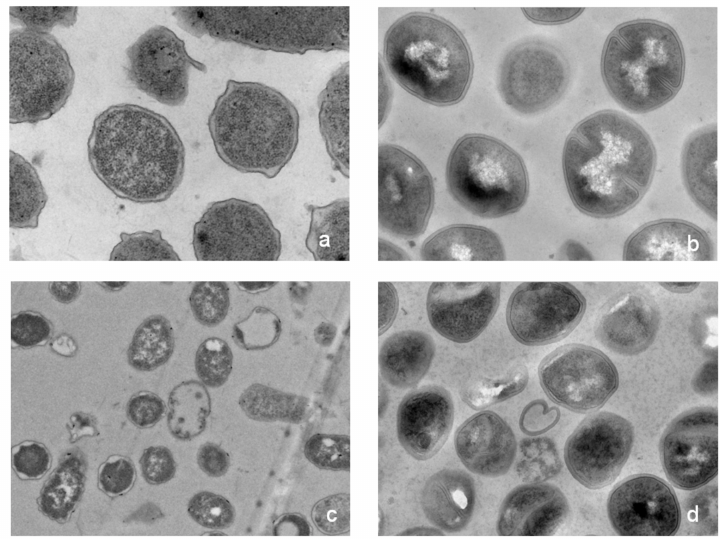
Figure 7. Transmission electron micrographs (TEM) of E. coli and S. aureus . Bacteria in mid-logarithmic growth were treated with peptides at 1 × MIC for three hours. ( a ) Normal E. coli control. ( b ) Normal S.aureus . ( c ) E. coli exposed to HJH-1. ( d ) S. aureus exposed to